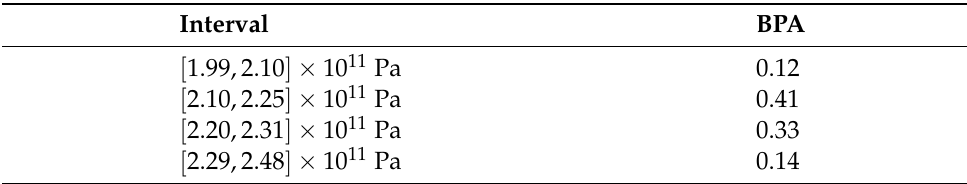
Table 3. Intervals and BPAs from Source